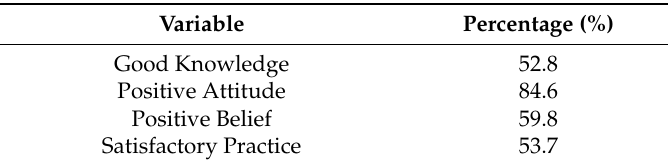
Table 2. Proportion of good knowledge, positive attitude, positive belief and satisfactory practice ( N = 214).